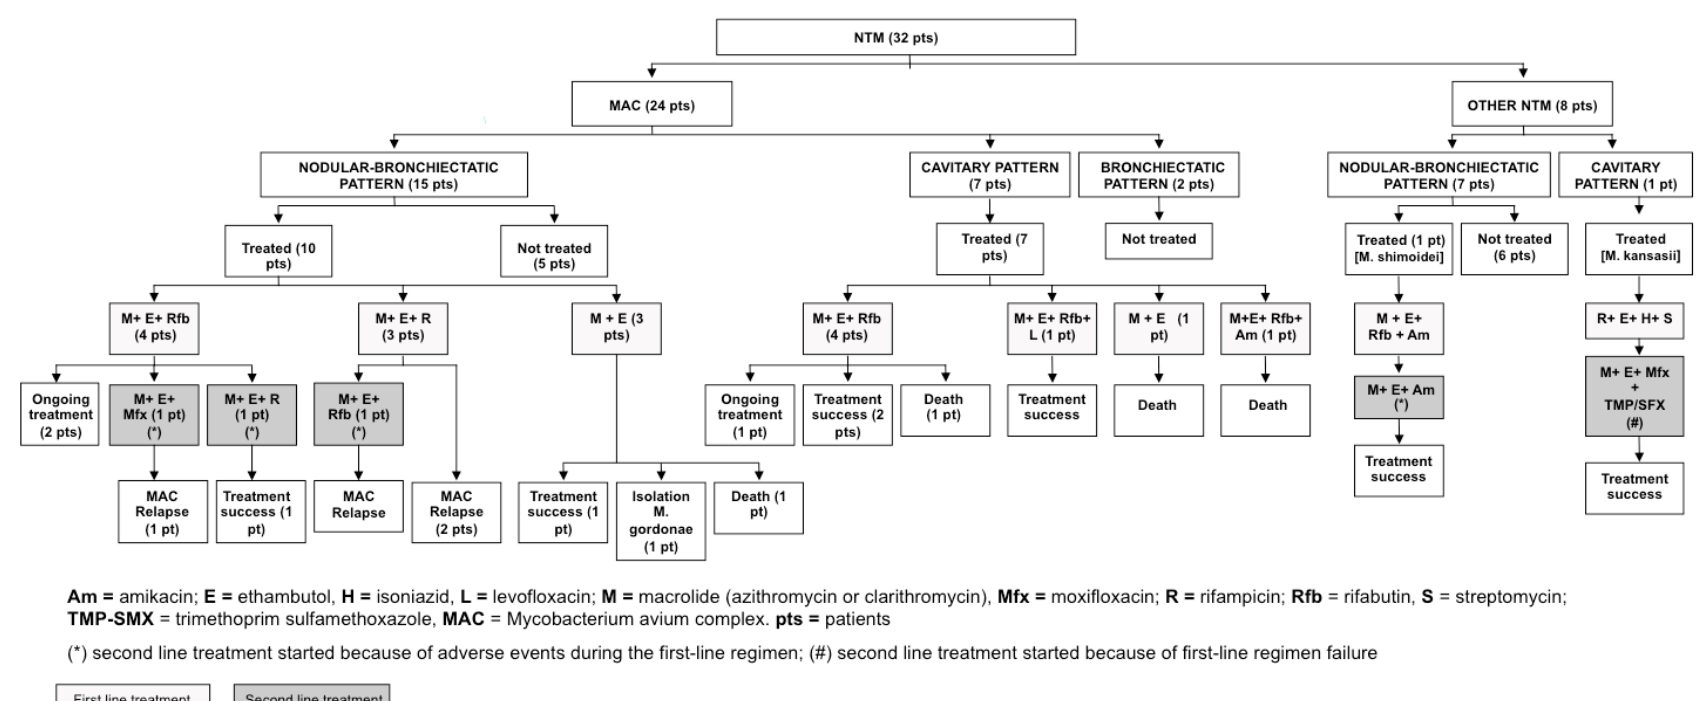
Figure 2. Therapeutic regimens and outcomes of adult bronchiectasis patients with pulmonary non-tuberculous mycobacteria disease according to the type of mycobacterium and the radiologic pattern.